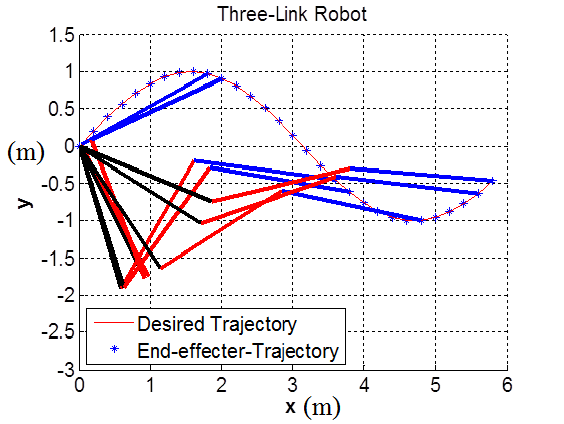
Fig. 8. The three link robot end effecter and the desired sinwave trajectories.